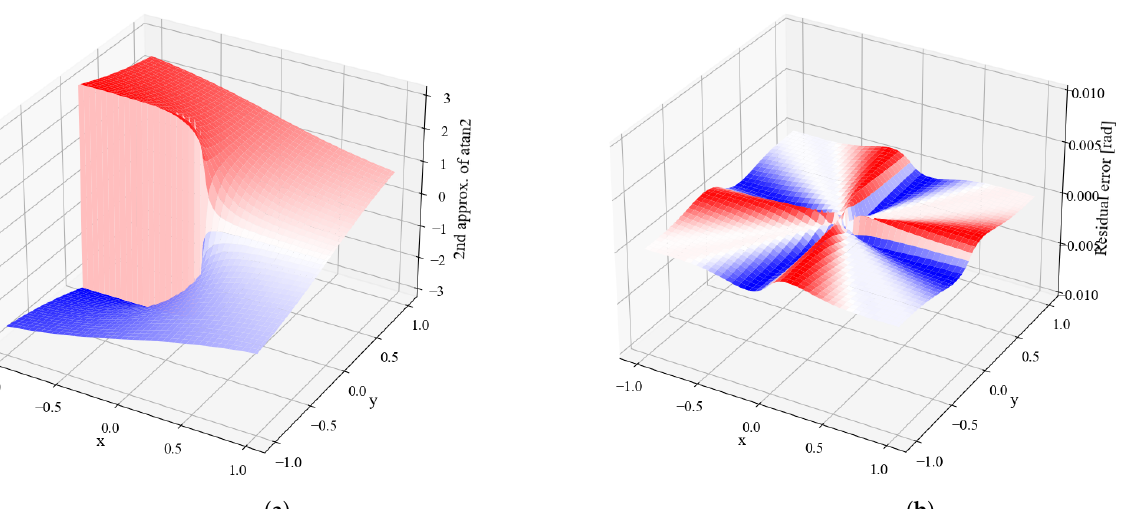
Figure 8. Atan2’s 2nd approximation with normalization using fast inverse square root(FISR) and its residual error. ( a ) Atan2 approx. over entire domain using FISR. ( b ) Error with atan2 in math